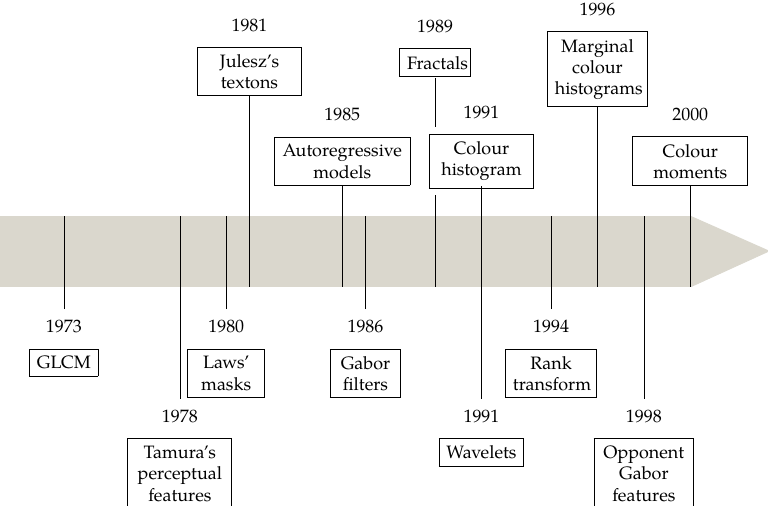
Figure 3. Colour and texture descriptors for visual recognition: chronology of the early